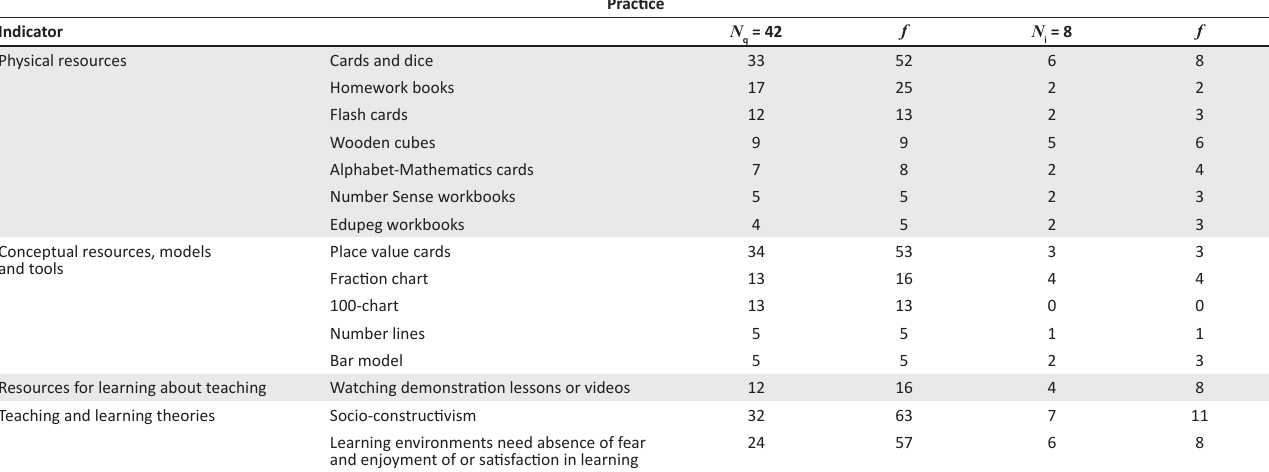
TABLE 2: Utterances of Numeracy Inquiry Community of Leader Educators’ practice-related affordances.